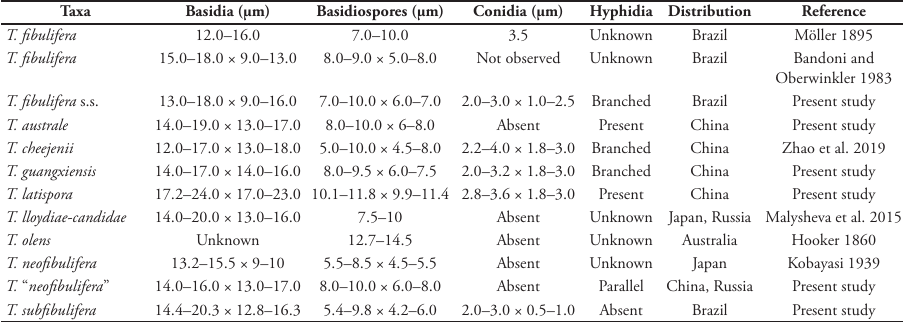
Table 3. A morphological comparison of taxa in the Tremella fibulifera